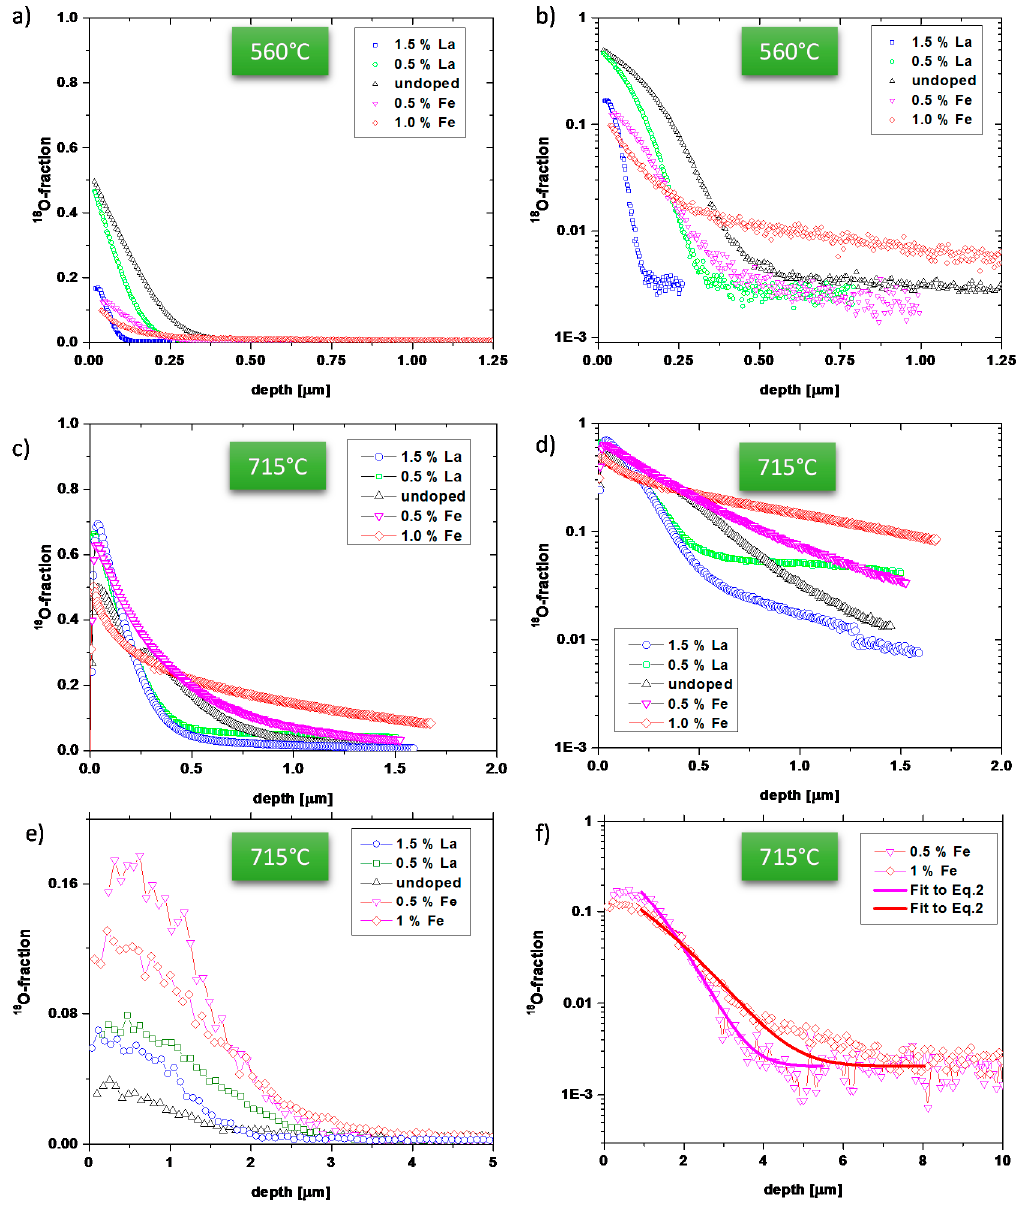
Figure 1. ( a ) Depth profiles of five differently doped lead zirconate titanate (PZT) samples in linear plots after tracer diffusion (30 min) at 560 °C; ( b ) logarithmic plots of the same profiles; ( c , d ) depth profiles of tracer exchange experiments at 715 °C (30 min) in linear plots ( c ) and logarithmic plots ( d ); ( e ) cross-sectional measurements after the tracer exchange experiments at 715 °C in linear plots; ( f ) cross-sectional profiles for 715 °C in logarithmic plots with fit curves (Equation (2)) for 0.5% and 1% Fe-doped samples.